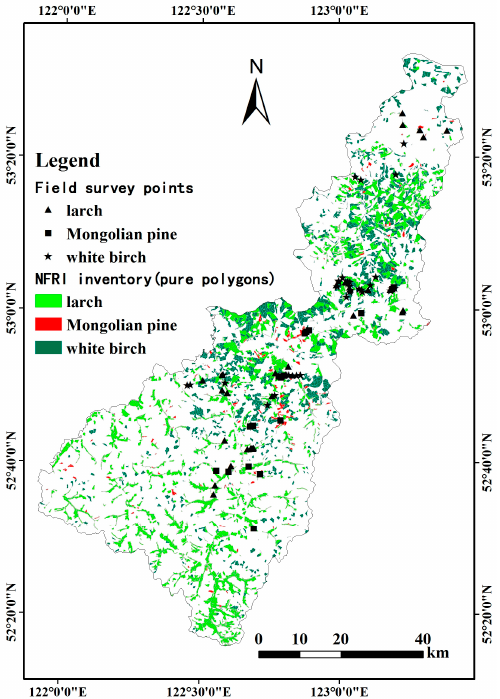
Figure 2. The NFRI unit polygons with pure stands and field survey points for the three tree species in the study area. Boundaries of unit polygons are also displayed.